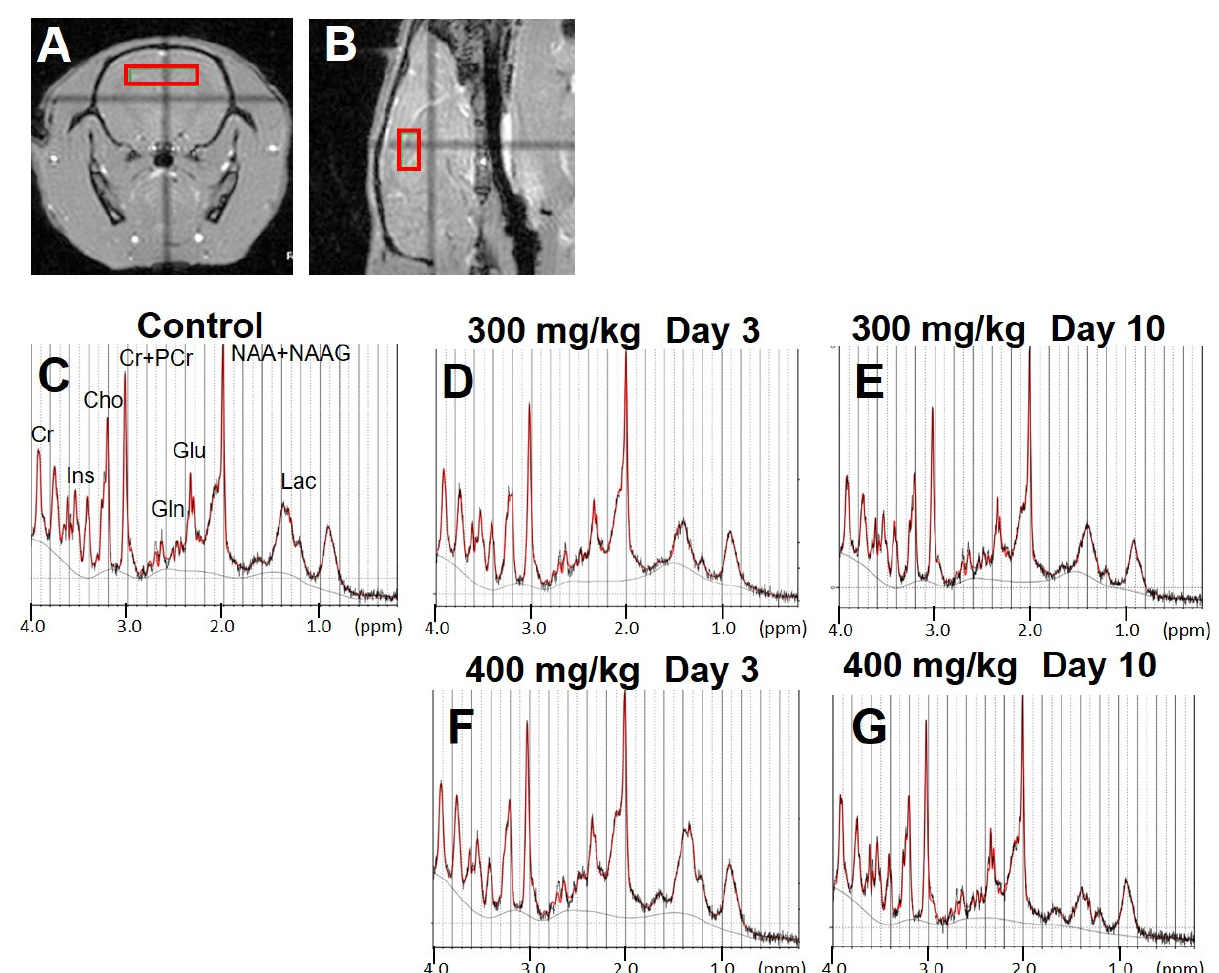
Figure 4. ( A,B ) show regions of interest in the hippocampus used for the analysis of MRS data. ( A ) is axial slice and ( B ) is sagittal slice sections. ( C – G ) indicate MR spectra compared to the control concentration. MRS, magnetic resonance spectroscopy. These five MR spectra show control ( C ), 300 mg/kg TAA injection ( D , E ), and 400 mg/kg TAA injection ( F , G ) groups. TAA, thioacetamide, NAA + NAAG, N-acetylaspartate + N-acetylaspartylglutamate; Cr + PCr, creatine + phosphocreatine; Cho, choline; Gln, glutamine; Glu, glutamate; Lac, lactate; Ins, myo-inositol.